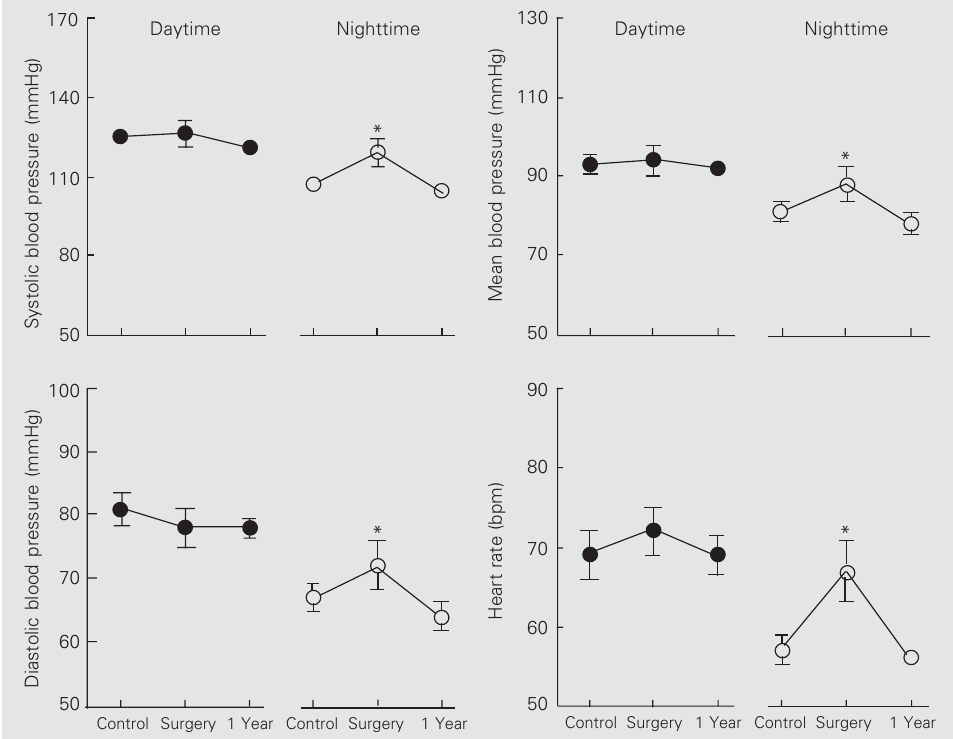
Figure 1. Systolic, diastolic and mean blood pressure and heart rate measured for 24 h in nor- motensive snorers one day be- fore surgery (control), on the day of uvulopalatoplasty sur- gery and one year later. Data are reported as means ± SEM. Asterisks indicate significantly higher values on the night of the day of surgery compared to control (P < 0.05, one-way